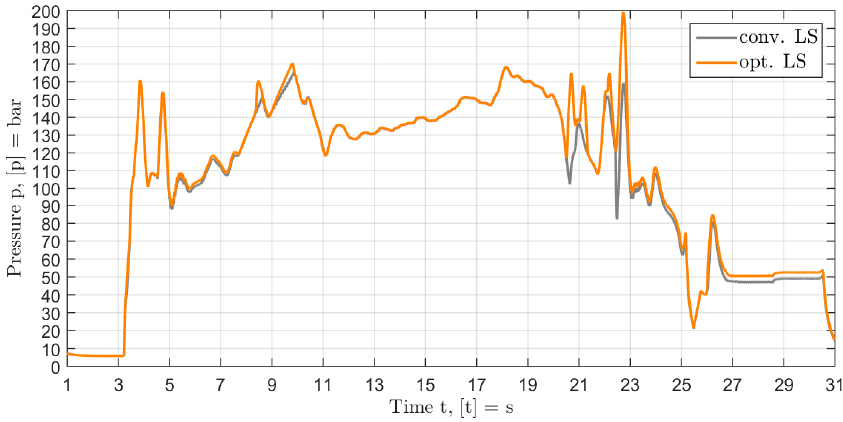
Figure 21. Comparison conv./opt. LS system: LS system pressure level p LS [9]. Reproduced with permission from the publisher.